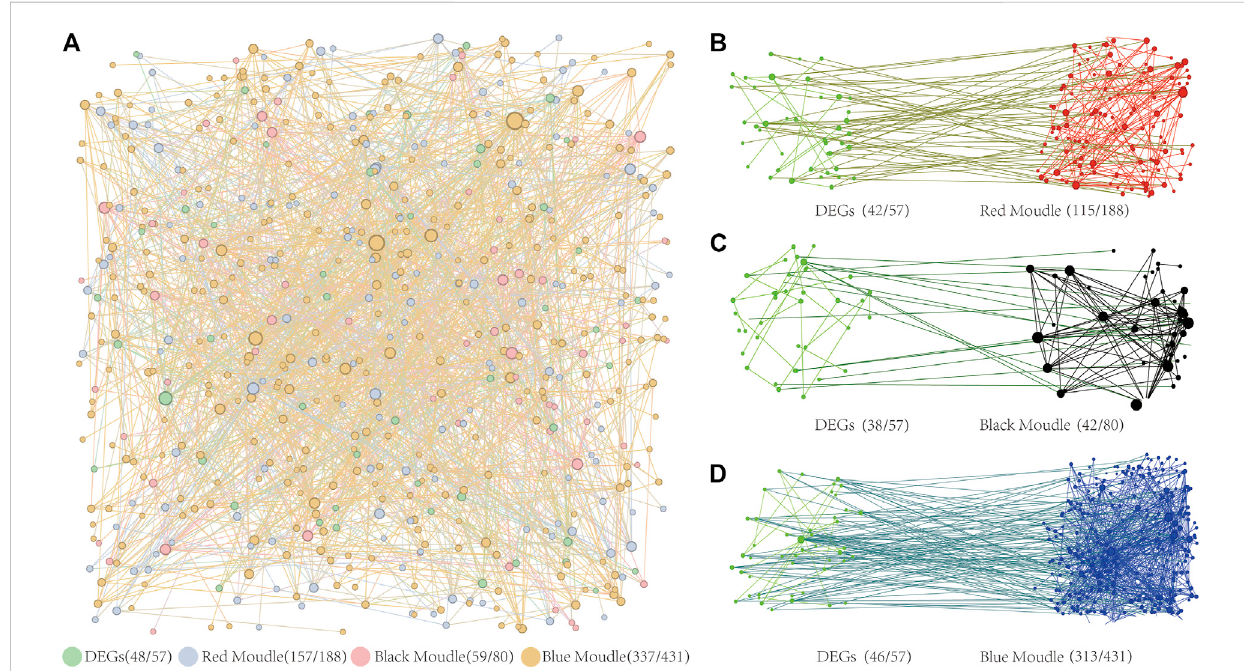
FIGURE 8 PPINetworkDiagram. (A) PPInetworkdiagramofthreekeymodulesanddifferentiallyexpressedgenes. (B) ThePPInetworkdiagramoftargetgenes regulatedbyBPC6anddifferentiallyexpressedgenesintheredmodule. (C) ThePPInetworkdiagramoftargetgenesregulatedbyBPC6anddifferentially expressed genes in the black module. (D) The PPI network diagram of target genes regulated by BPC6 and differentially expressed genes in the blue